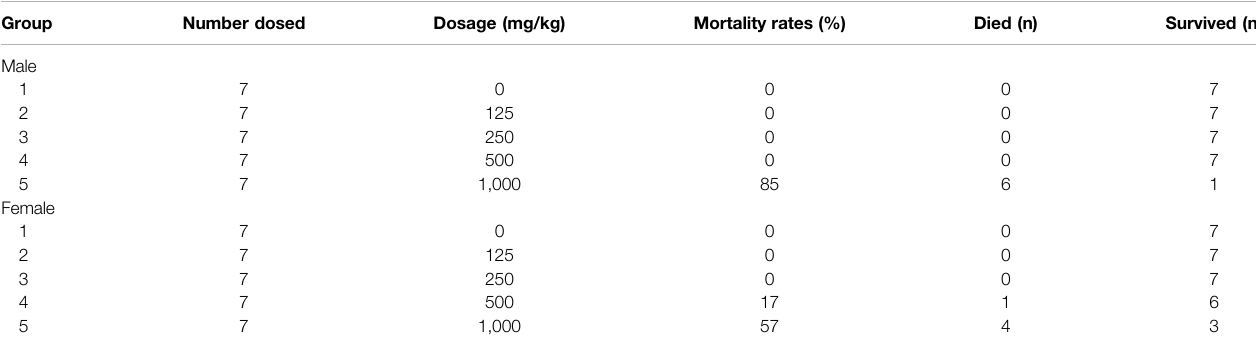
TABLE 2 | The death of rats during the 28-day dose toxicity